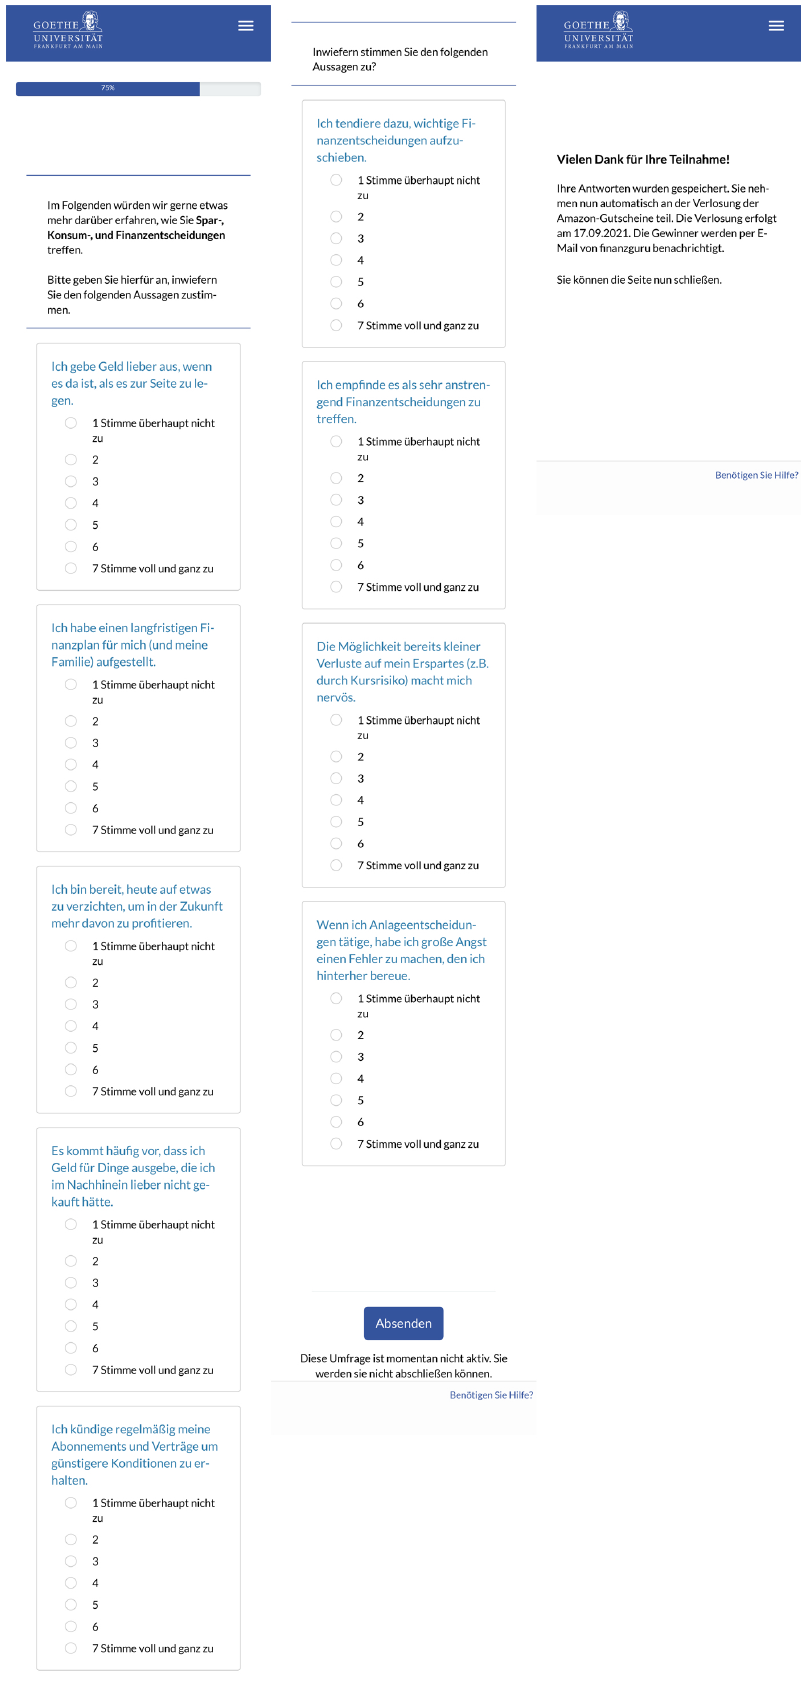
Figure A4. Survey mobile version (page 7–8). Source: Own